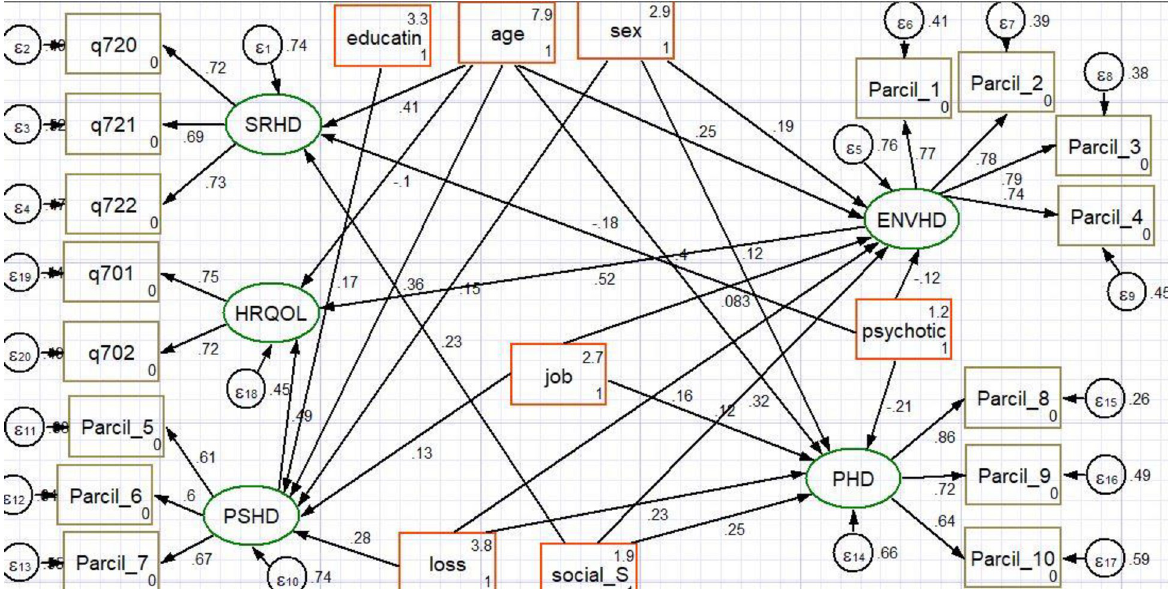
Fig 4. SEM for factors associated with HRQOL for substance youths in central Gondar zone, 2021. Where, PHD: Physical health domain, ENVHD: Environmental health domain, SRHD: Social relations domain, PSHD: Psychological health domain, parcil_1: Average of Q7 and Q13, parcil_2: Average of Q14 and Q24, parcil_3: Average of Q8 and Q23, parcil_4: Average of Q12 and Q25, parcil_5: Average of Q5 and Q11, parcil_6: Average of Q19 and Q7, parcil_7 = average of Q6 and Q26, parcil_8 = average of Q3, Q10 and Q17, parcil_9 = average of Q4 and Q16 parcil_10 = the average of Q18 and Q15, Resi: Residents of patients, education: Educational level of the youths, loss: Loss of beloved family, Social_S: Social support, psychotic: Psychotic symptoms of the youths, job: Job status of the youth.